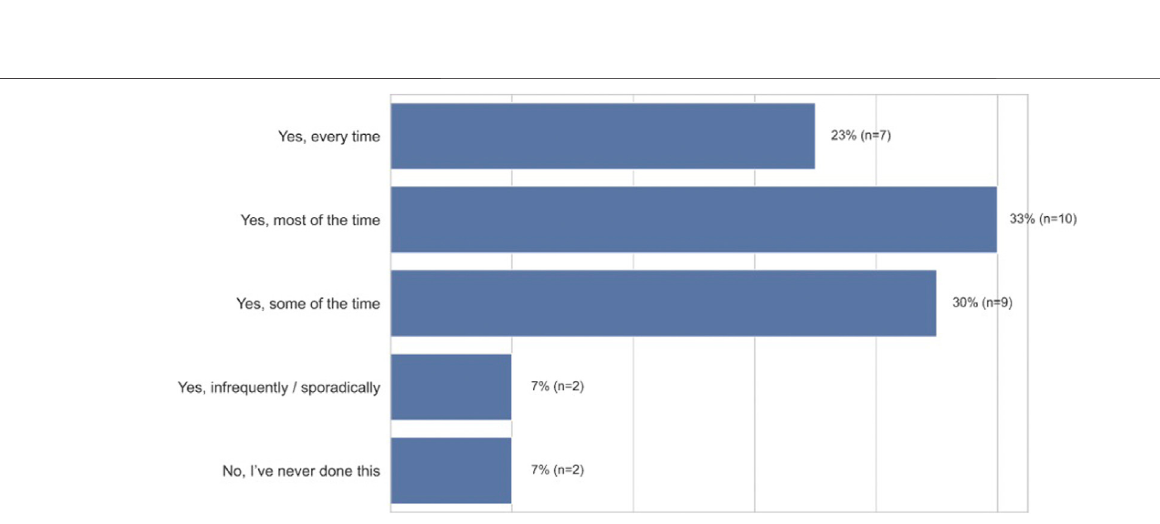
Frontiers in Arti fi cial Intelligence |